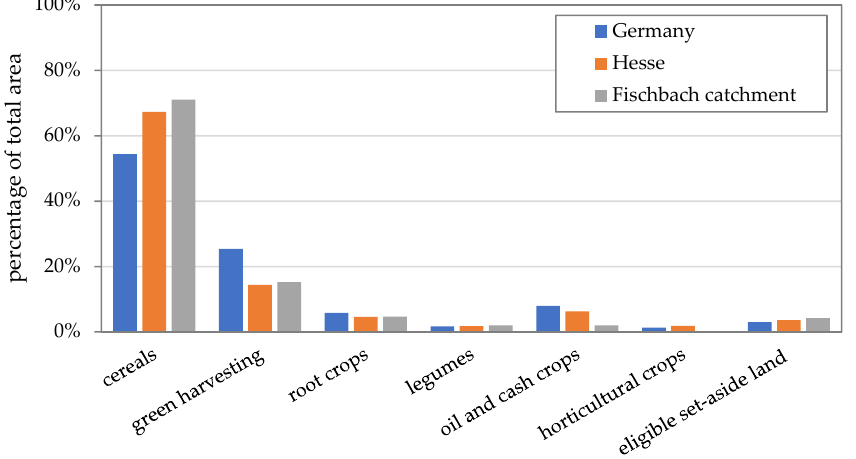
Figure 5. Distribution of various categories of cultivated area in comparison for Germany, Hesse, and the Fischbach catchment in 2019 (categories < 0.2% not considered); data source: [40,61].